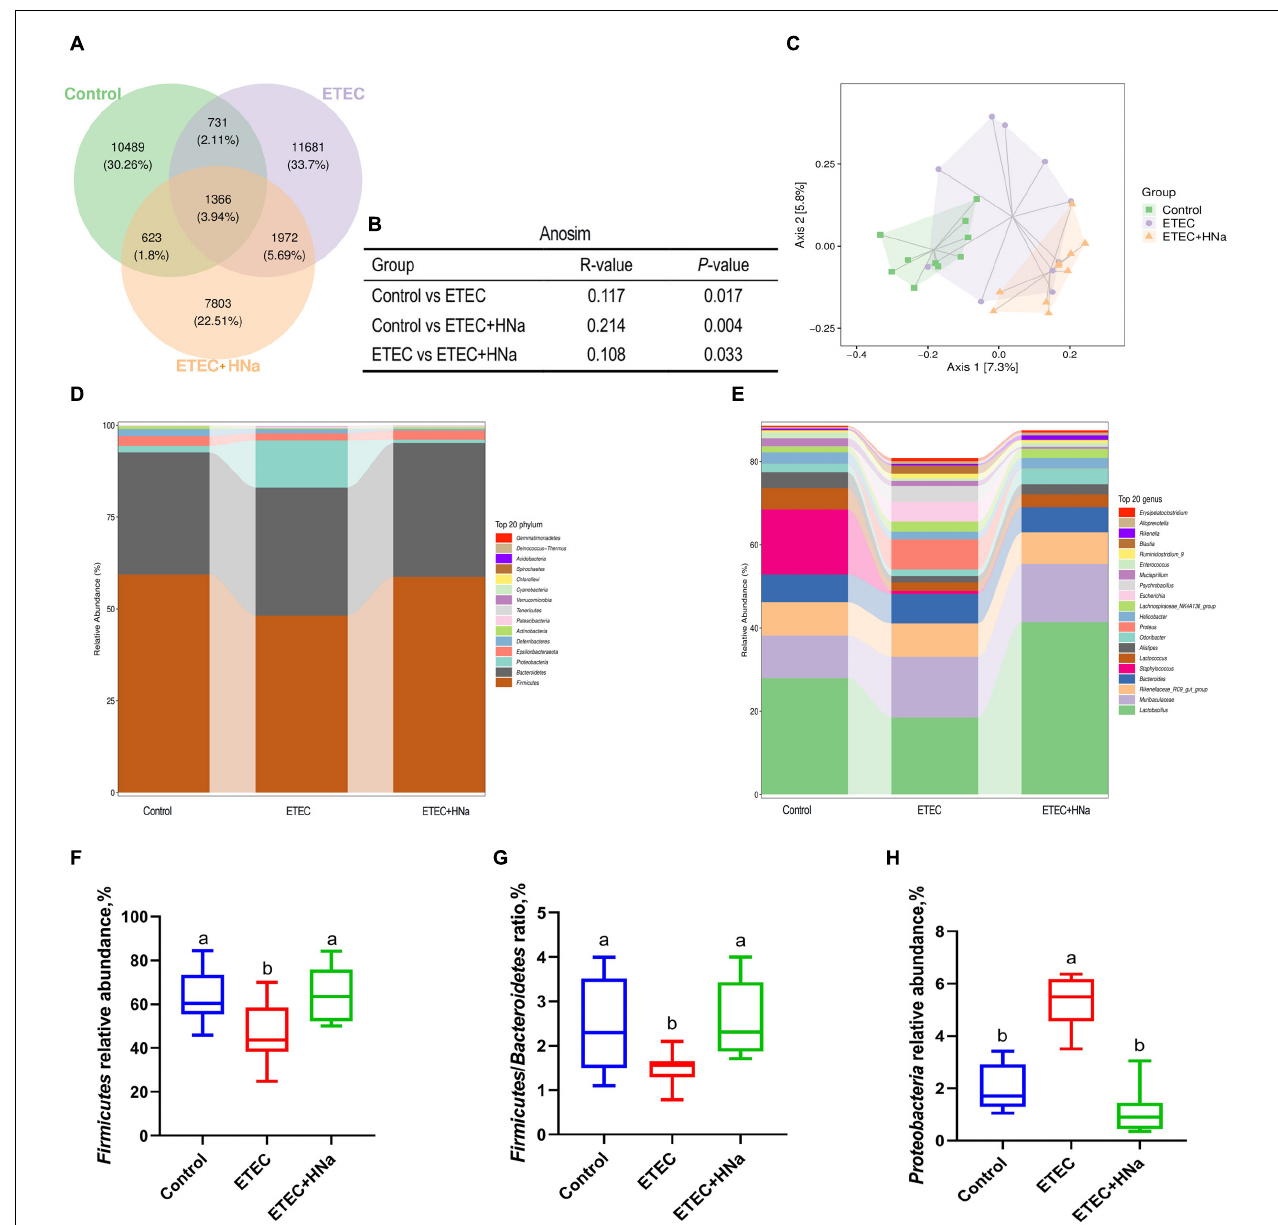
FIGURE 5 | Effects of sodium humate on intestinal microbiota composition of ETEC K88-infected mice. (A) A Venn diagram displayed the overlaps among groups ( n = 10). (B) Anosim analysis among groups. (C) Principal co-ordinates analysis (PCoA) plot of intestinal microbiota; each represented by one color ( n = 10). Community bar plots of phylum and genus level were shown in (D,E) . (F) The relative abundance of Firmicutes . (G) The ratio of Firmicutes to Bacteroidetes . (H) The relative abundance of Proteobacteria . All of the data are expressed as the mean ± SEM. Different superscript lowercase letters within each group indicate significantly different values ( P <